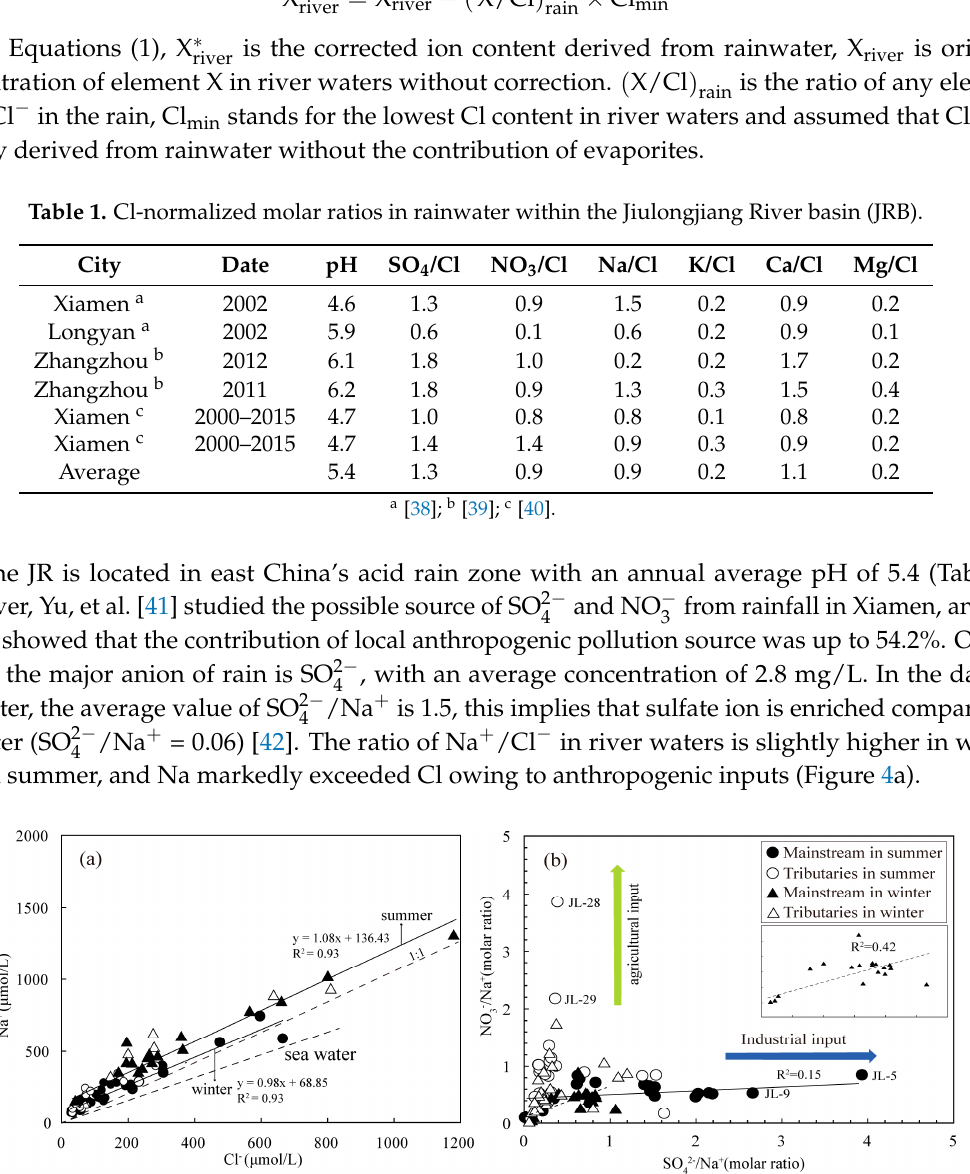
/Na + and SO 2 − /Na + for river waters 3 4